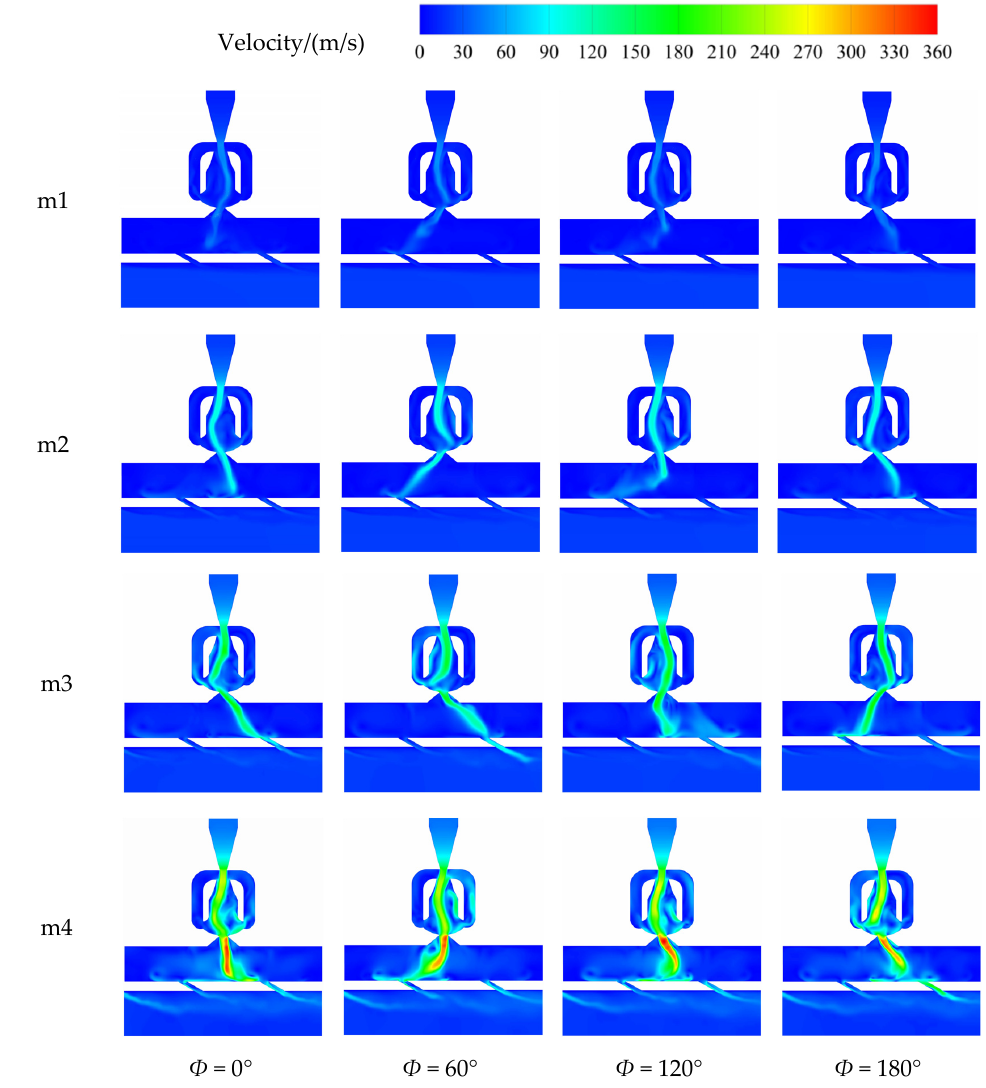
Figure 5. Instantaneous velocity magnitude (front view) for α = 30° at various phase angles and mass flow rates.